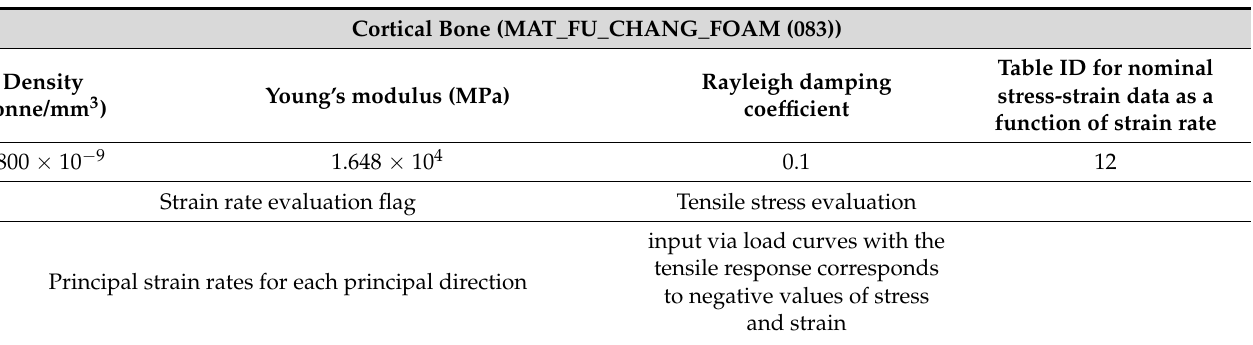
Table A5. Mechanical properties of tissues and